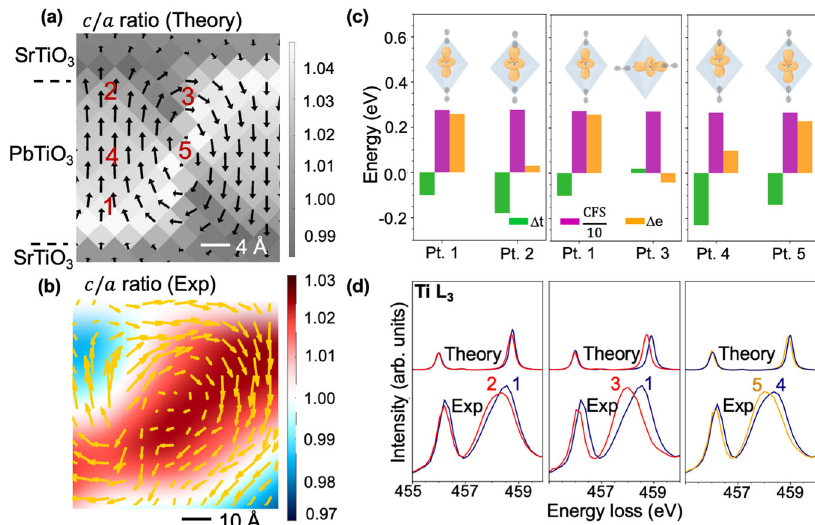
Fig. 4 ab initio and multiplet calculations compared to experimental EELS. a Theoretical local polarization pro fi le of polydomain structures in PTO/STO superlattices. Background gray scale represents the local tetragonality. b Experimental polar displacement of A sites with c/a ratio maps overlaid in the background. c Change in crystal fi eld parameters ( 4 e g in orange, 4 t 2 g in green, and CFS in magenta) at fi ve different positions of the Ti 4 + ions within the superlattice, as indicated in a . The inset shows the overlapping of the Ti 3 d z 2 orbital and the O 2 p orbital as the c = a ratio (points 1 and 2), the direction (points 1 and 3), and magnitude (points 4 and 5) of the Ti 4 + displacement. d Comparison of multiplet calculated EEL spectra using parameters in b as inputs and experimental EEL spectra for the fi ve Ti 4 +